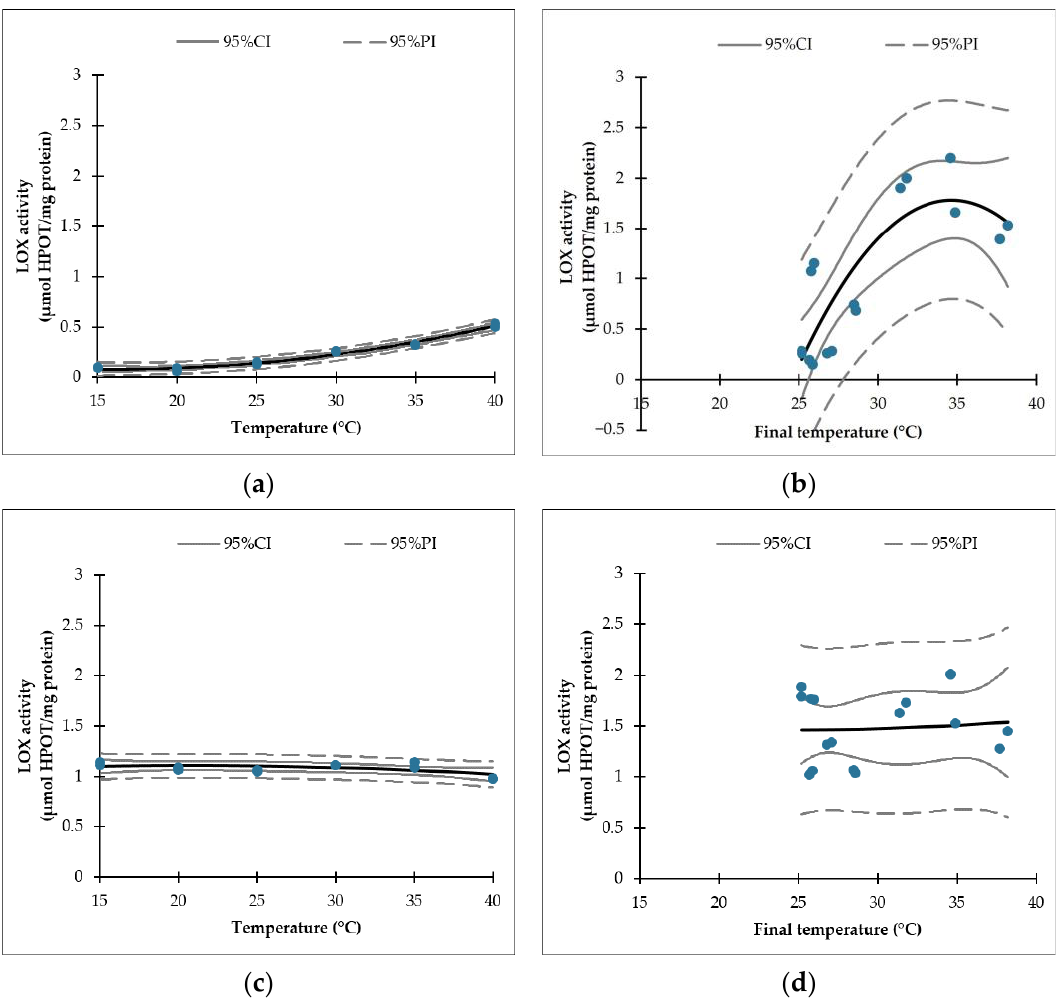
Figure 3. Second-order nonlinear function for LOX activity as a function of temperature for: ( a ) thermal treatment (TT), ( b ) ultrasonic treatment (US), ( c ) TT and incubation for 30 min at 25 °C, and ( d ) US and incubation for 30 min at 25 °C. The black line represents the model curve, the gray solid line (95% CI) represents the 95% confidence interval, and the gray dashed line (95% PI) represents the 95% prediction interval. The circles represent the plot-level data points. Table 4. Parameter estimates of the exponential curve for lipoxygenase (LOX) activity as a function of